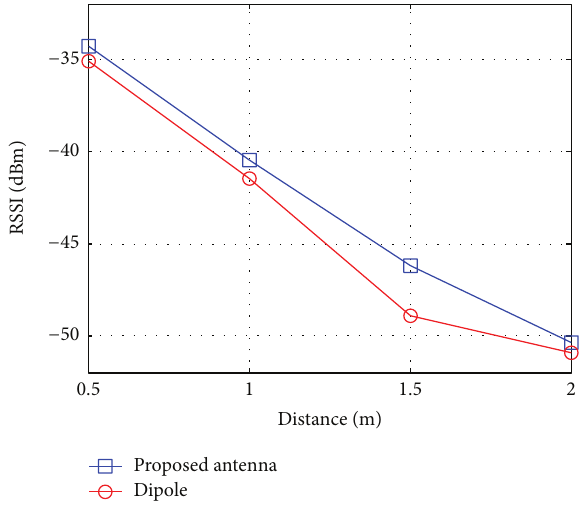
Figure 18: Measured RSSI versus distance in the anechoic box without a human body in the vicinity.